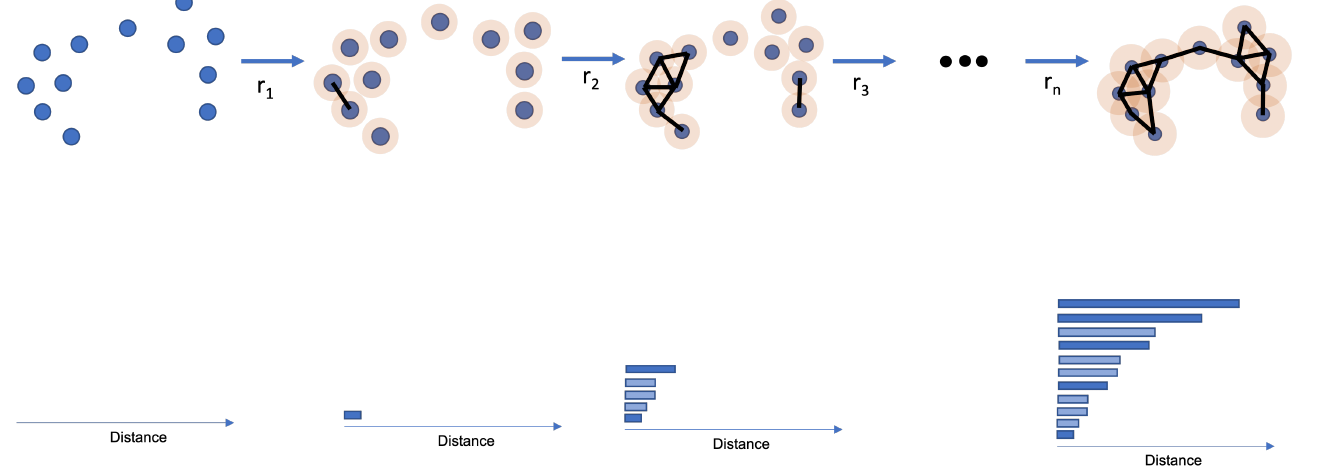
Figure 1. Example of a 0-dimensional Persistent Homology Analysis. At the top, the connections between points form as r increases. At the bottom, the barcode originated from the analysis. Each bar represents the distance at which a component has